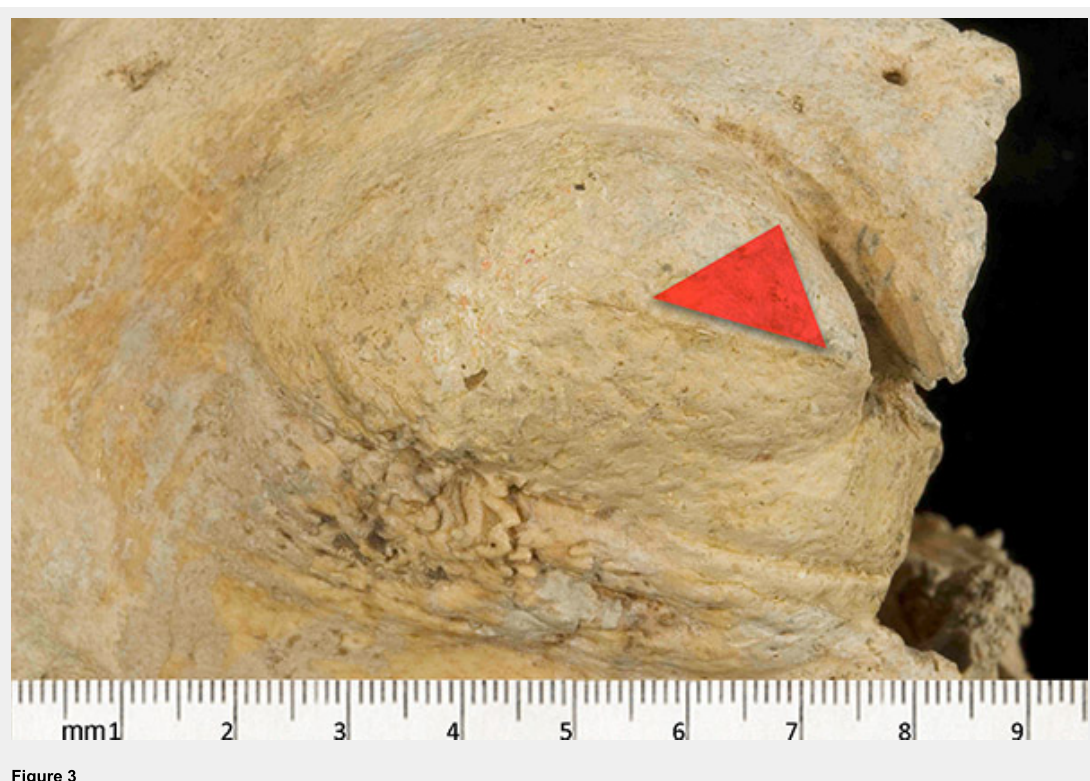
Figure 3 Location of sampling for histological analysis (red